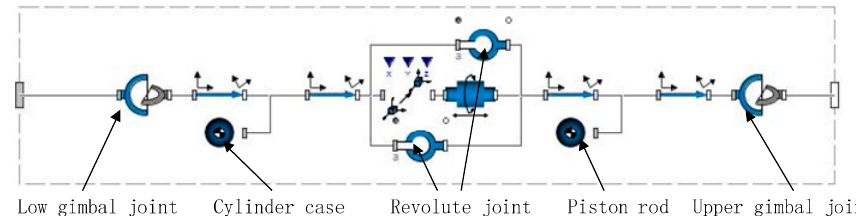
Figure 5. Schematic diagram of the cylinder model in the simulation model.